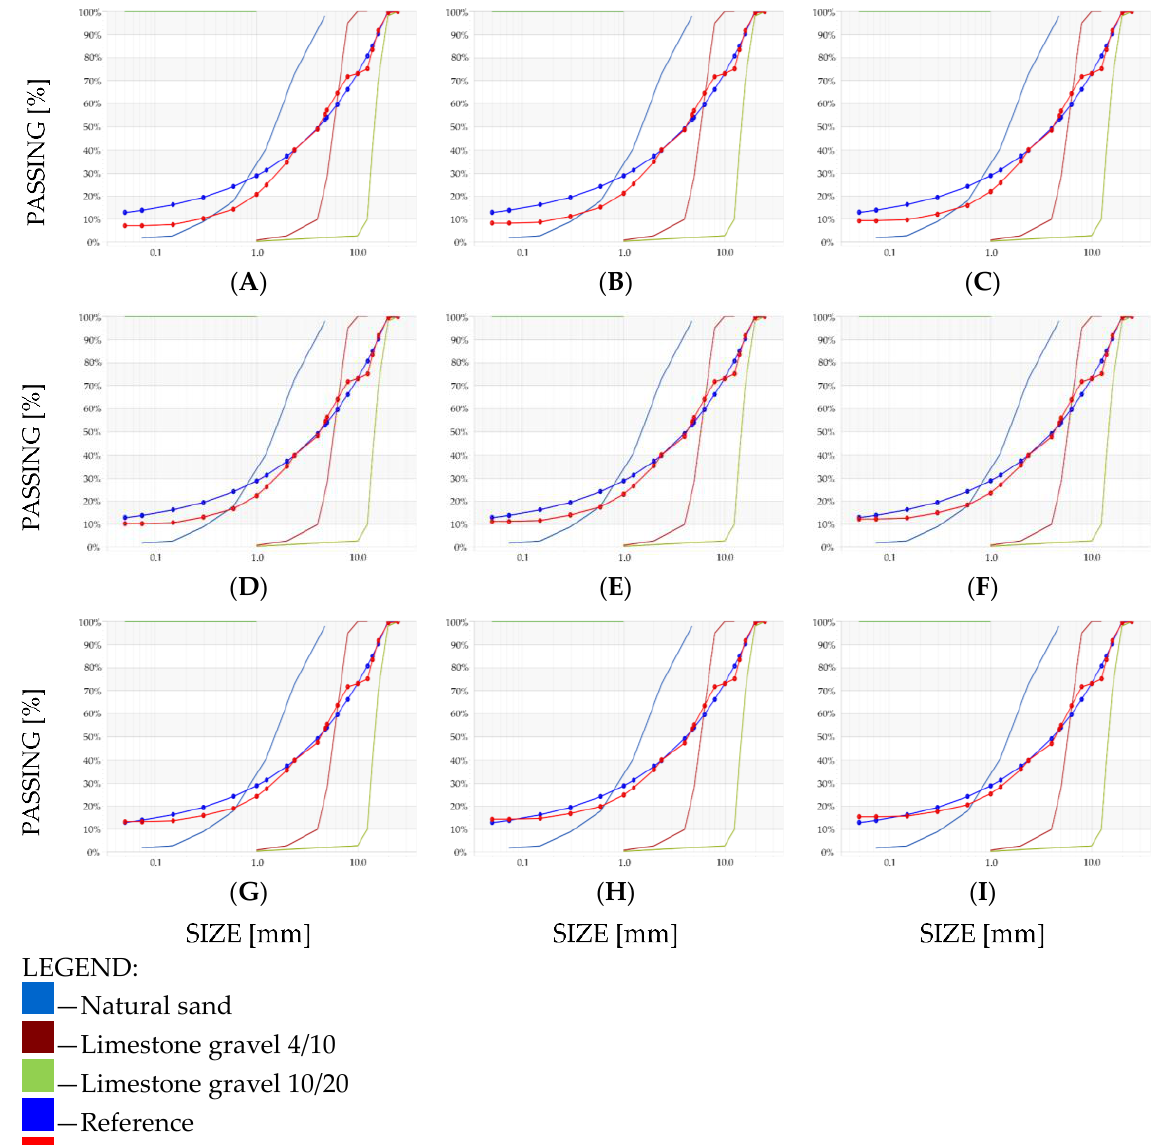
Figure A1. Gradings and fitting curves for Recipe #1—standard mix with plasticizer (lignosulfonate) and superplasticizer (polycarboxylate ether) designed according to the Bolomey Method: ( A ) 10 MPa; ( B ) 15 MPa; ( C ) 20 MPa; ( D ) 25 MPa; ( E ) 30 MPa; ( F ) 35 MPa; ( G ) 40 MPa; ( H ) 45 MPa; ( I ) 50 MPa. Legend in the left bottom corner.